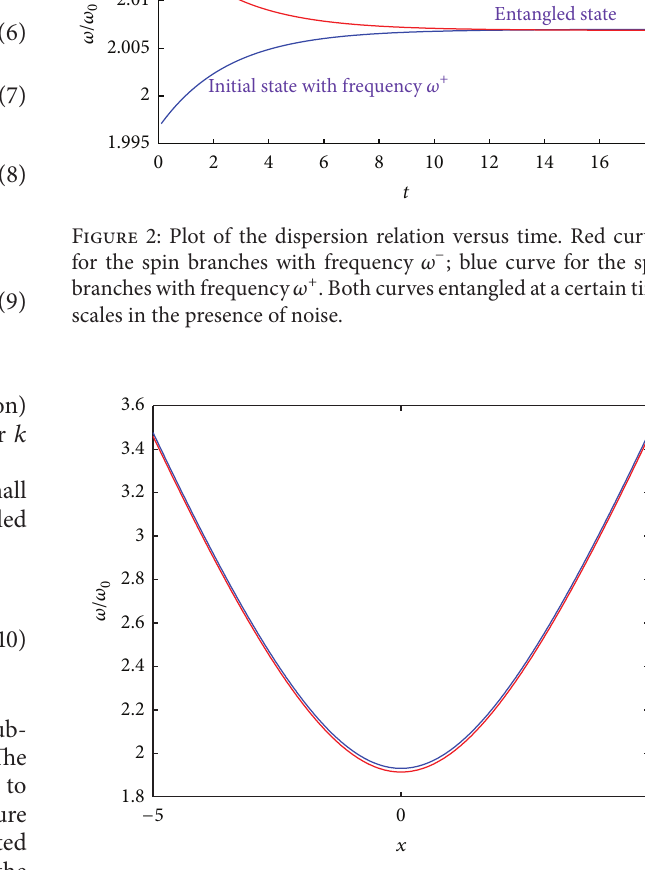
Figure 3: Plot of the dispersion relation versus the wave vector ( 𝑥 = 𝑘𝑙 ). Red curves for the spin branches with frequency 𝜔 − ; blue curve for the spin branches with frequency 𝜔 + . Both curves show basin- like